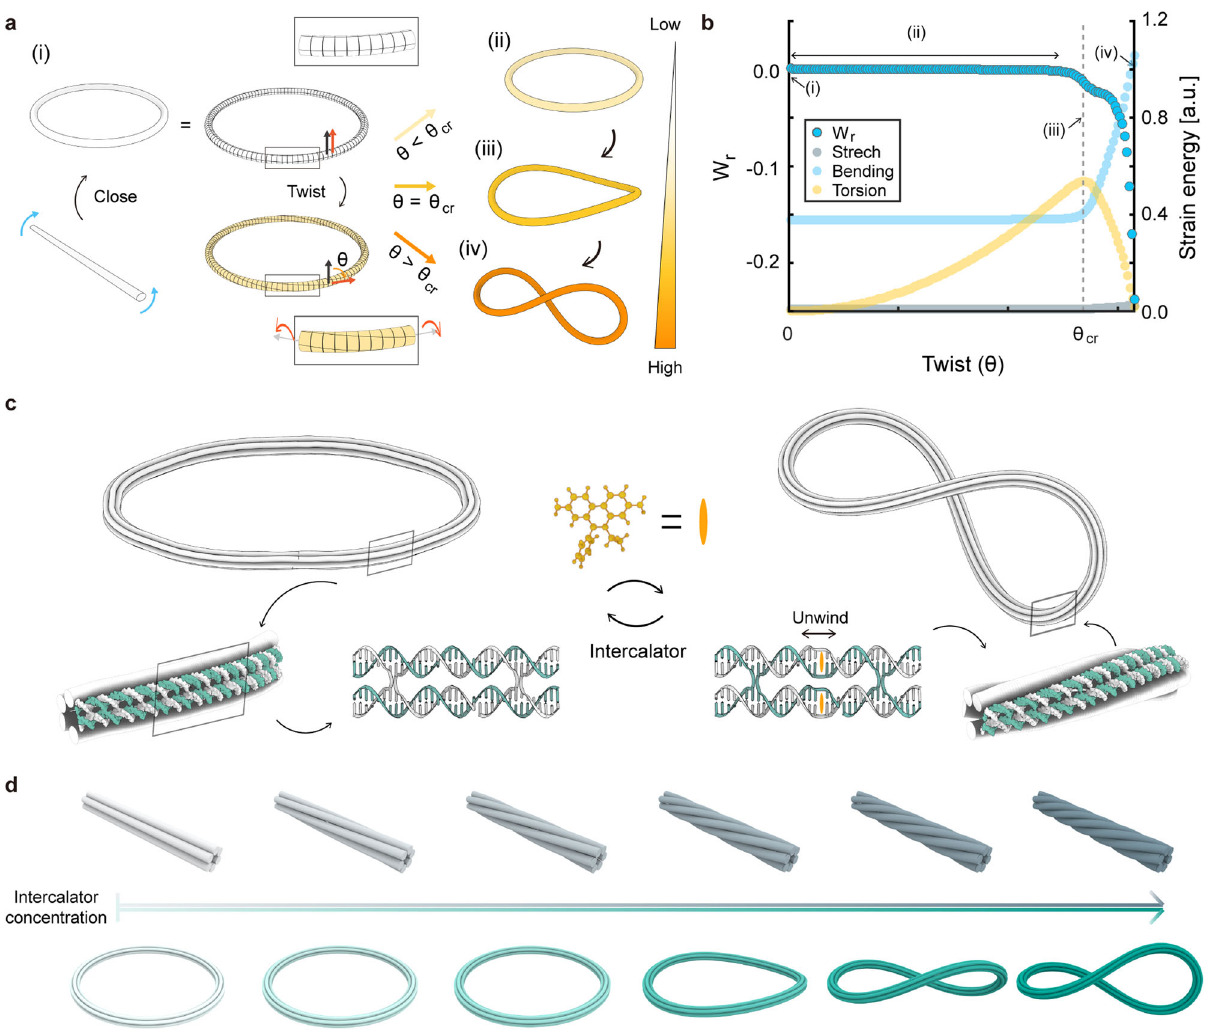
Fig. 1 Chemomechanical instability of DNA rings. a Michell ’ s instability. A ring structure is formed by joining both ends of a straight rod with a certain amount of twist. Color bar represents the applied twist angle ( θ ). θ cr denotes the critical angle triggering the instability. b Writhe (W r ) and the strain energy of the ring as a function of the applied twist angle. c Realizing Michell ’ s instability with DNA rings. Intercalators perturb the geometry of DNA when bound and induce torsional stress on the ring. d A topologically unconstrained straight bundle (top) shows a gradual recon fi guration with respect to the concentration of an intercalator, while an ultrasensitive threshold recon fi guration occurs for a topologically constrained ring structure